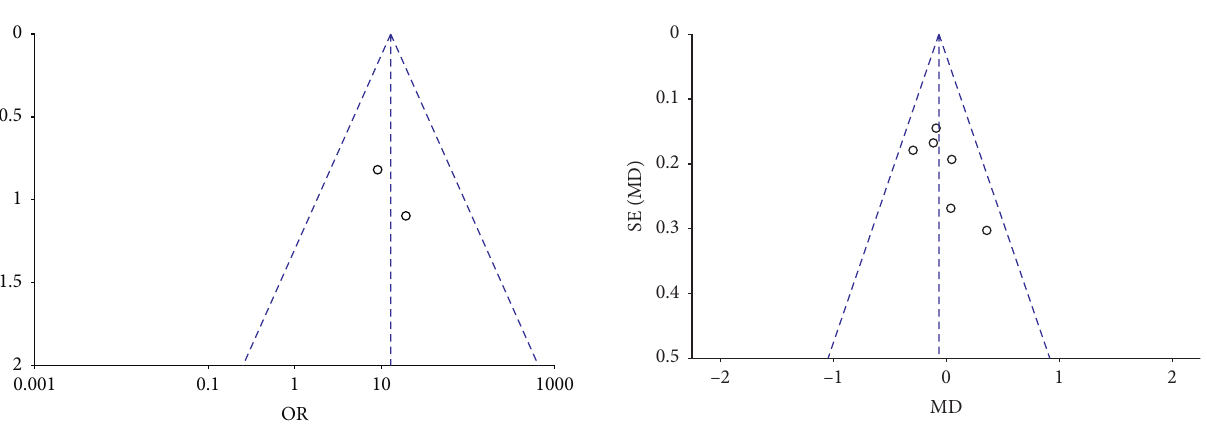
Figure 9: A funnel plot of MH closure rate at 12 months after surgery showing no significant publication bias. MH � macular hole, SE � standard error, OR � odds ratio.